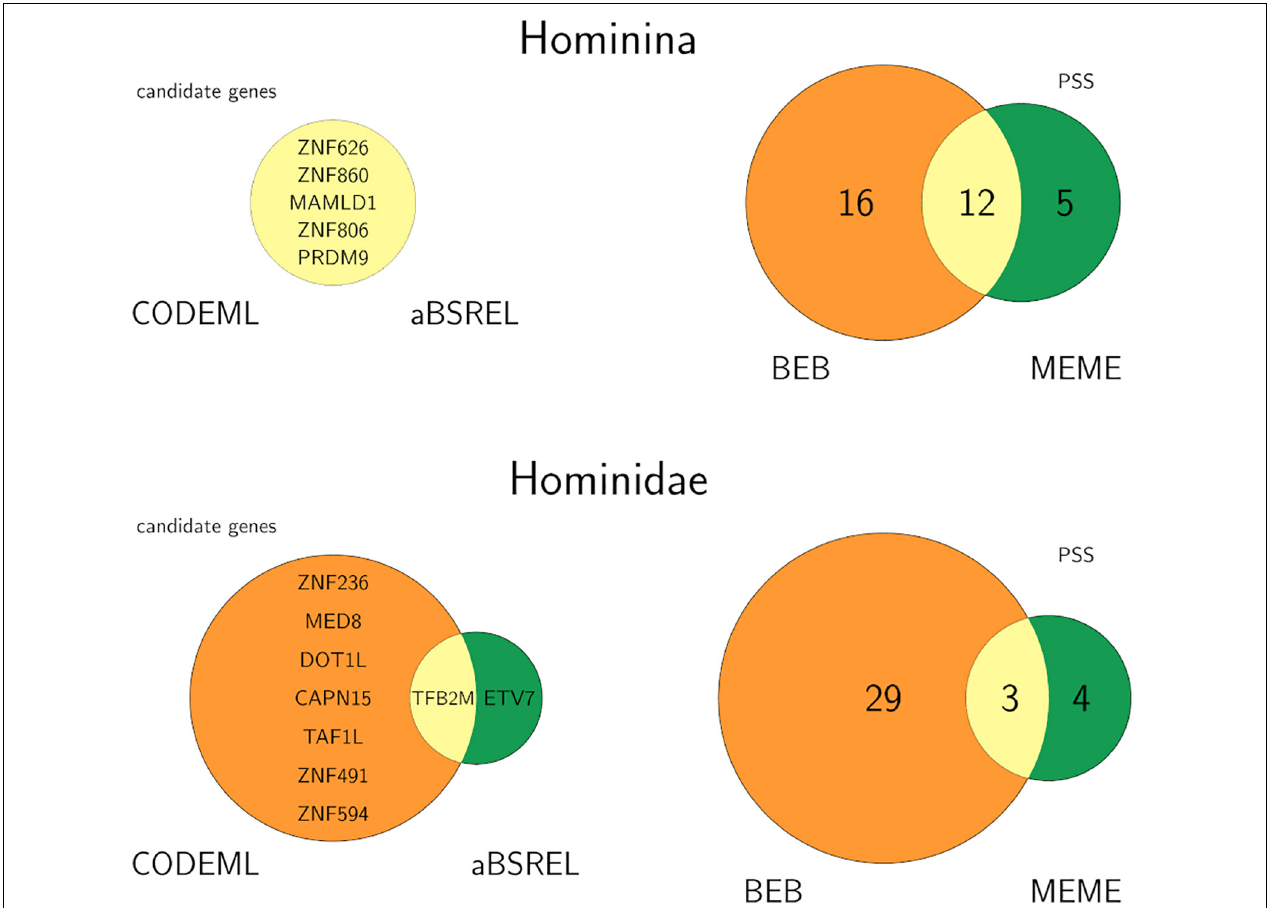
FIGURE 3 | Venn diagrams of PAML (orange) and HyPhy (green) results and their overlap (yellow). The names of the candidate genes and the number of positively selected sites are indicated. Upper row: branch-site selected GRFs (left) and total PSS (right) for the human branch, lower row: the same for the great ape